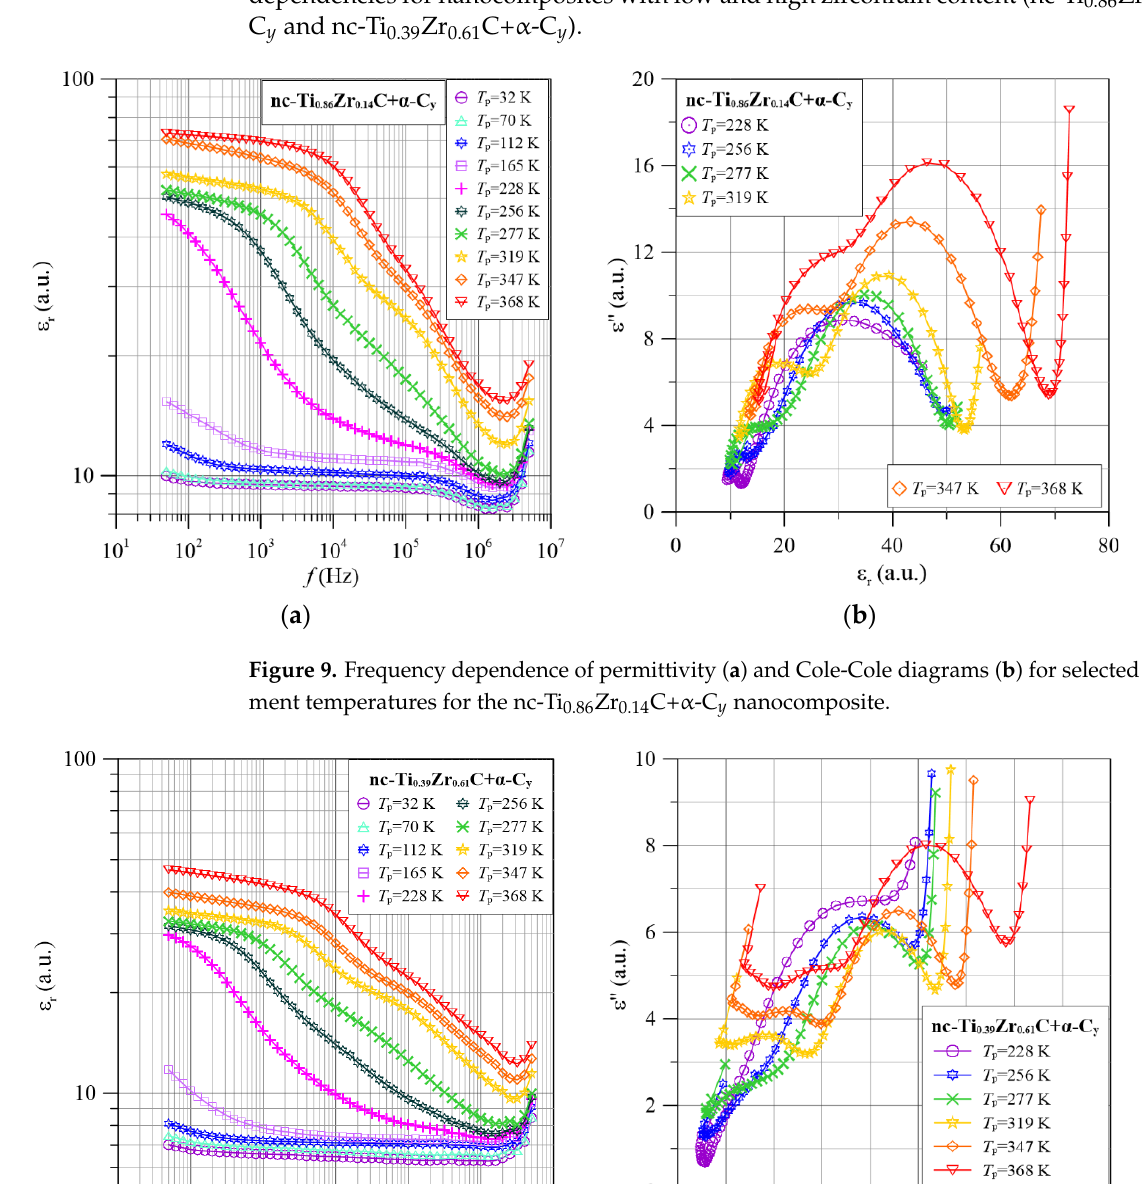
Figure 10. Frequency dependence of permittivity ( a ) and Cole ‐ Cole diagrams ( b ) for selected measurement temperatures for the nc ‐ Ti 0.39 Zr 0.61 C+ α‐ C y nanocomposite.